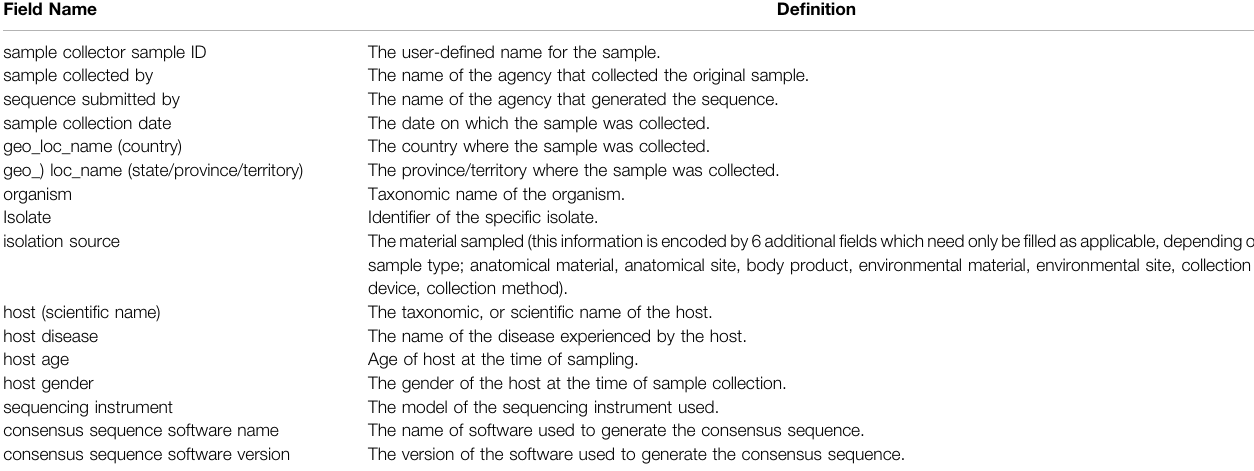
TABLE 1 | MIxS Compliance and Implementation Metadata Standards (Genomics Standards Consortium,